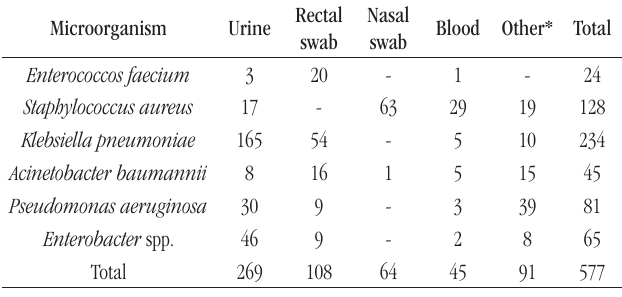
taBLE 3 − Microorganisms by sample type between 2010 and 2015 Microorganism